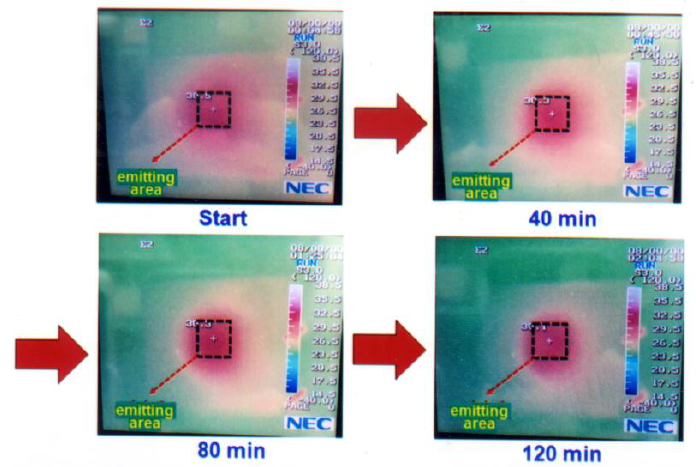
Figure 9. Under 5 mA constant current driven, the surface temperature and infrared thermal images of the OLED at different times (the middle square marked is the emitting area).